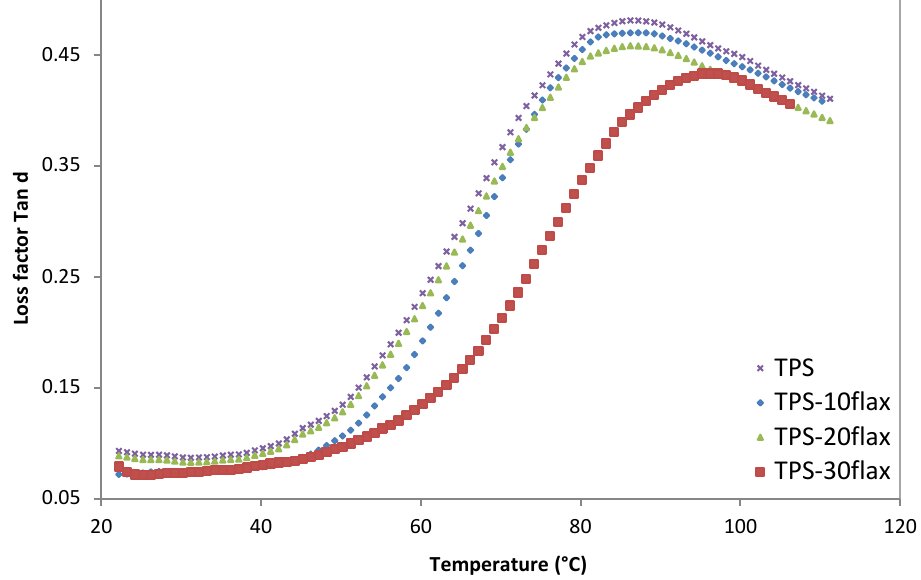
Figure 13. Evolution of the tan δ factor for TPS and TPS/(% percentage) shives of flax as a function of temperature.